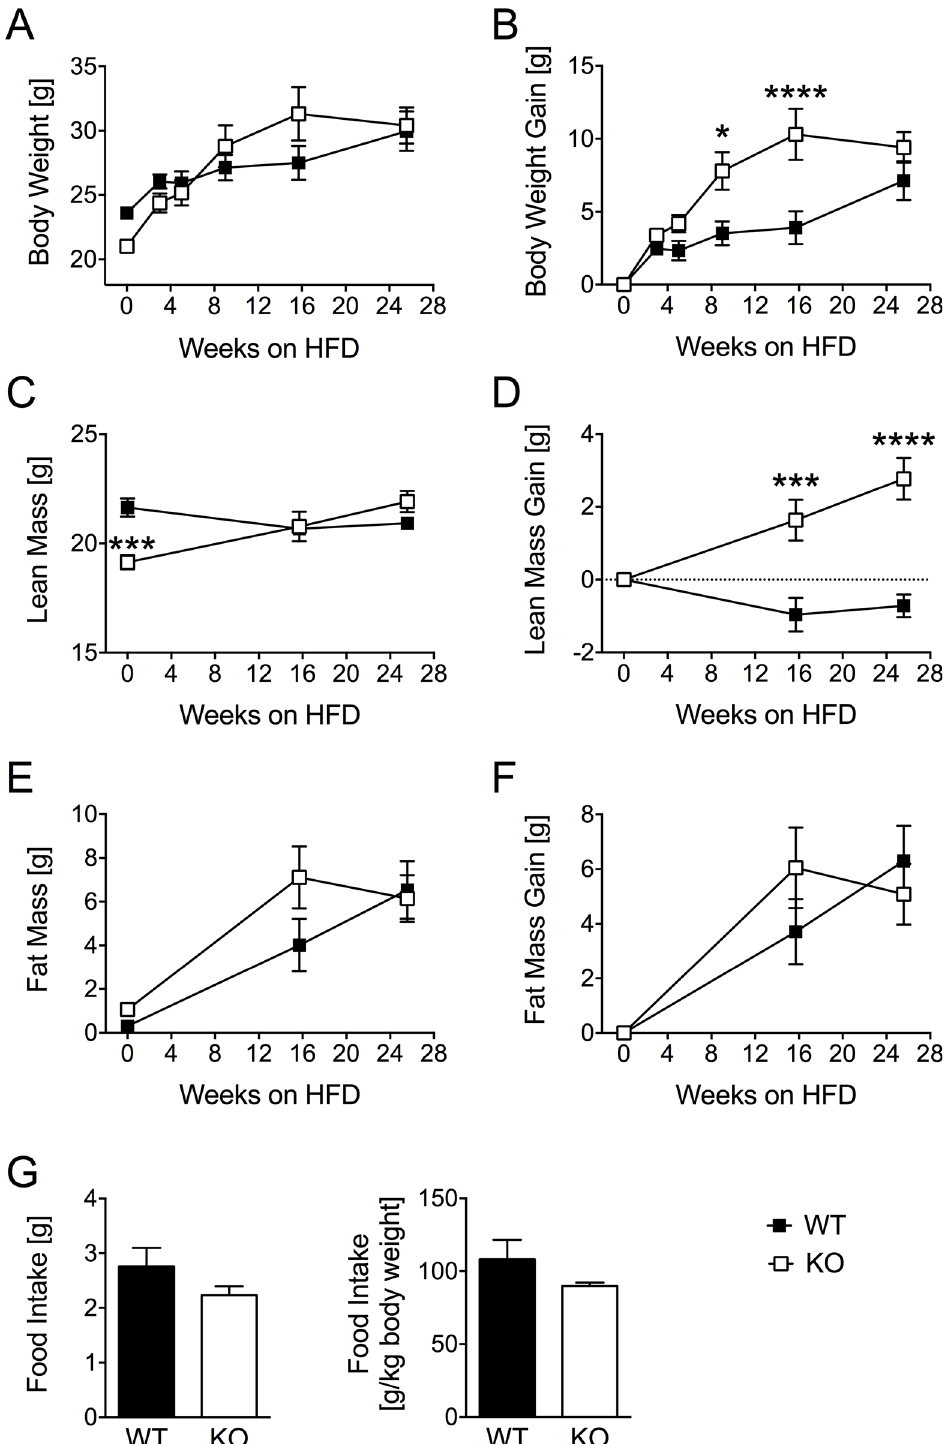
Fig 4. Body weight and body composition in HFD-fed DUSP6 WT and KO mice. DUSP6 WT and KO mice were exposedto high fat diet (HFD; D12331;58% kcal fat; ResearchDiets Inc., New Brunswick,USA) for 25 weeks, and evaluatedfor changes in body weight (A,B), lean mass (C,D) and fat mass (E,F). Food intake per animal or kg body weight was monitored betweenweeks 3 and 5 (G). A-F: n = 8–9; G: n = 3–5 (group housedmice). Means ± SEM, *** p < 0.001, **** p < 0.0001.